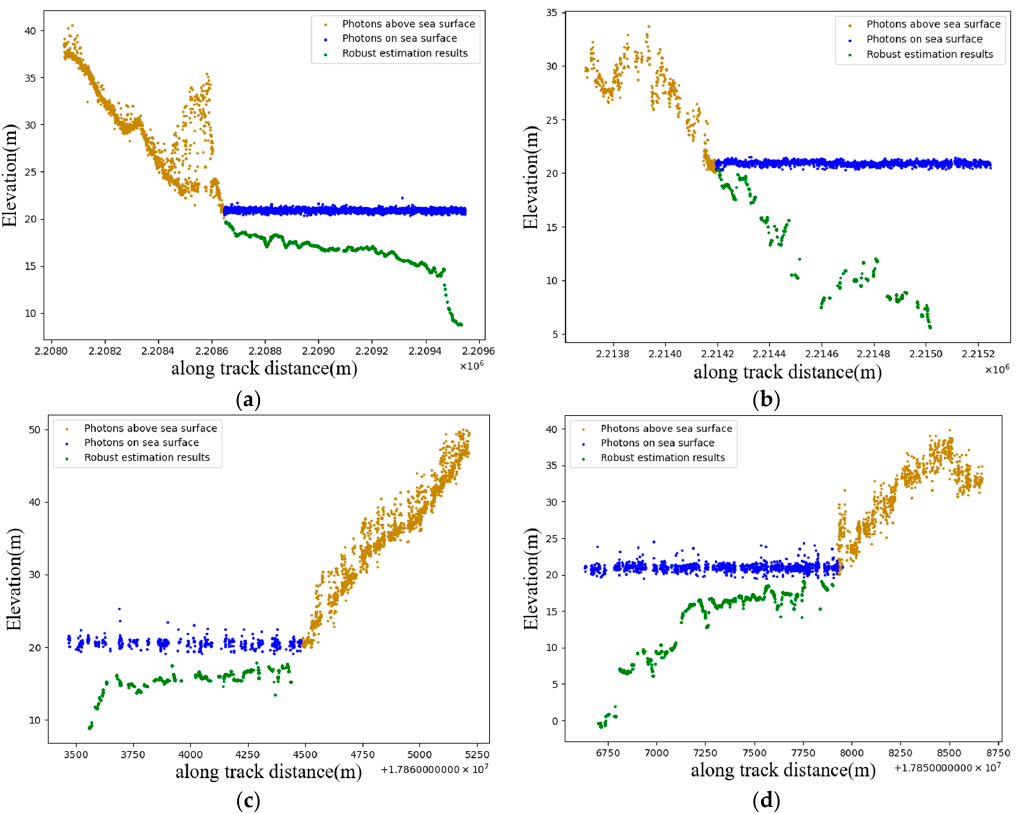
Figure 11. ( a ) Point pro fi le of bathymetric estimation of 480 orbit gt1r beam; ( b ) point pro fi le of bathymetric estimation of 480 orbit gt2r beam; ( c ) point pro fi le of bathymetric estimation of 1036 orbit gt2r beam; ( d ) p oint pro fi le of bathymetric estimation of 1036 orbit gt1r beam.